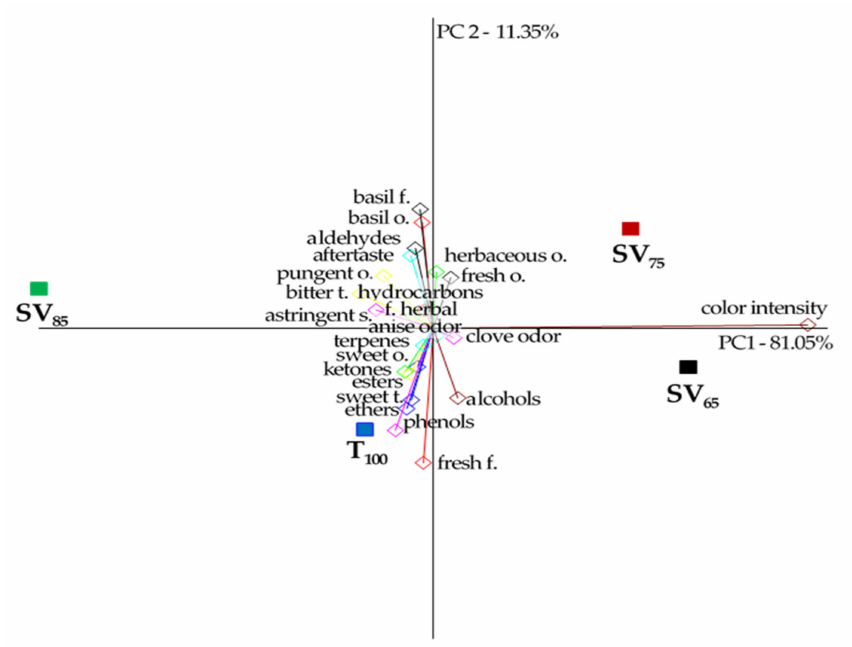
Figure 1. Principal components analysis (PCA) biplot of basil infusions (SV 65 , SV 75 , SV 85 , and T 100